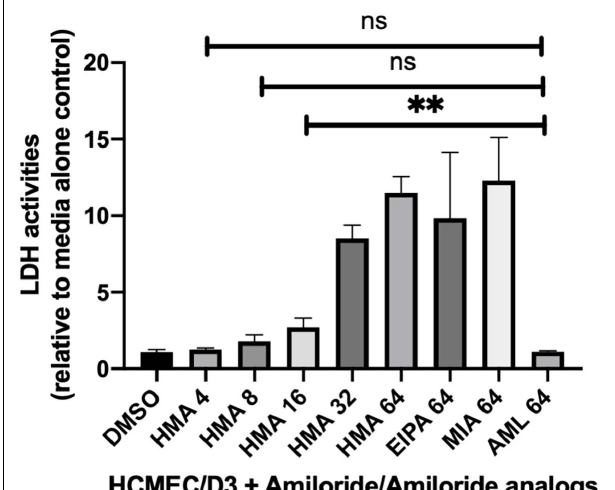
FIGURE 2 | Lactate dehydrogenase (LDH) activity assays in mammalian cells treated with HMA indicate little to no cytotoxicity at concentrations of HMA ≤ 8 µ g/ml. The human cerebral microvascular endothelial cell line (HCMEC/D3) was treated with either amiloride (AML) or the amiloride analogs (HMA, EIPA, MIA) at the indicated concentrations (4, 8, 16, 32, or 64 µ g/ml) for 8 h prior to measuring LDH activity. The cytotoxicity of HMA at 8